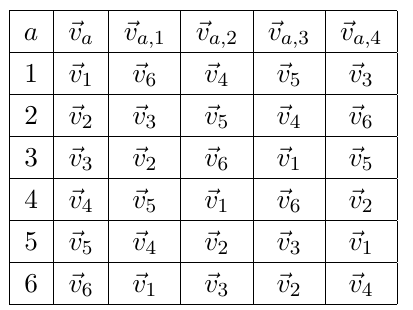
Table 5 . Vectors used to compute the master volume of Y p;k ( C P 1 (cid:2) C P 1